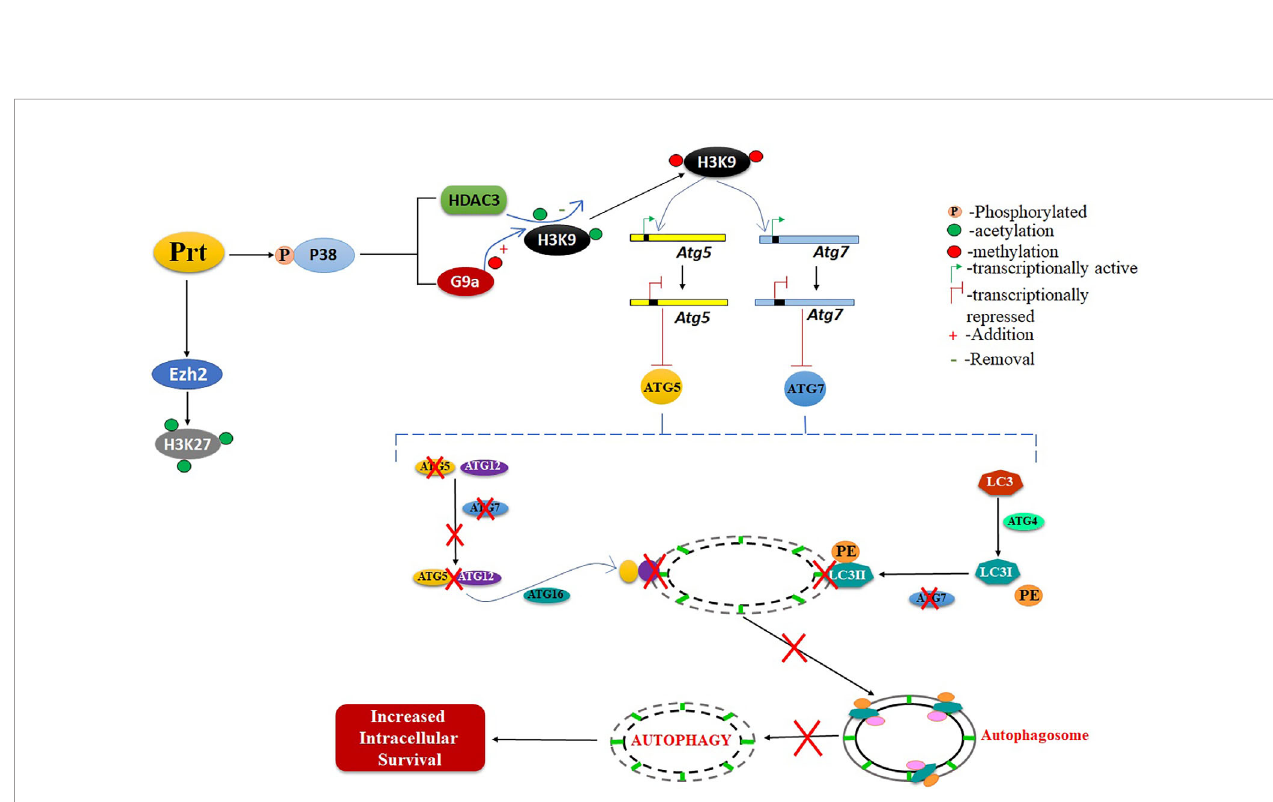
FIGURE 6 | Schematic representation of role of Mtb PRT in induction of histone hypermethylation, which down regulates the autophagy. This downregulation of autophagy leads to increased intracellular